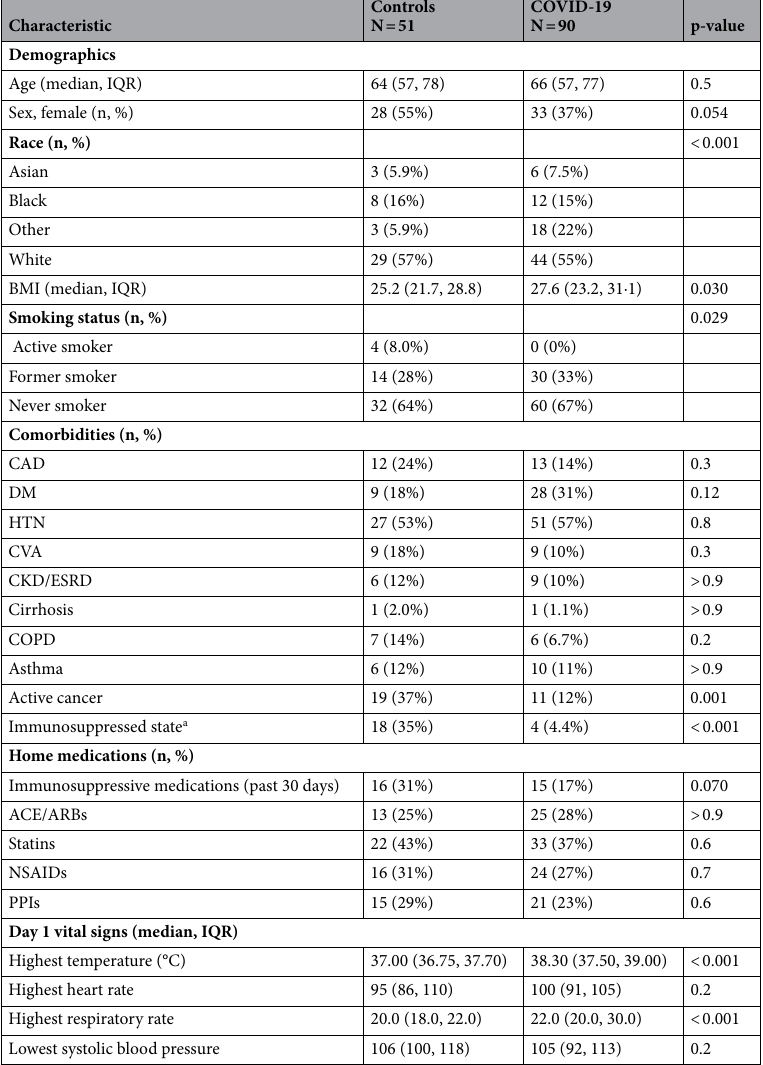
Table 1. Demographics and baseline characteristics of COVID-19 patients and controls. BMI Body Mass Index, CAD coronary artery disease, DM diabetes mellitus, HTN hypertension, CVA cerebrovascular accident, CKD/ESRD chronic kidney disease/end stage renal disease, COPD chronic obstructive pulmonary disease, ACE/ARBs angiotensin-converting enzyme inhibitors/angiotensin-II receptor blockers, NSAIDs nonsteroidal anti-inflammatory drugs, PPIs proton pump inhibitors. a Chemotherapy or radiotherapy within last 6 months; inherited